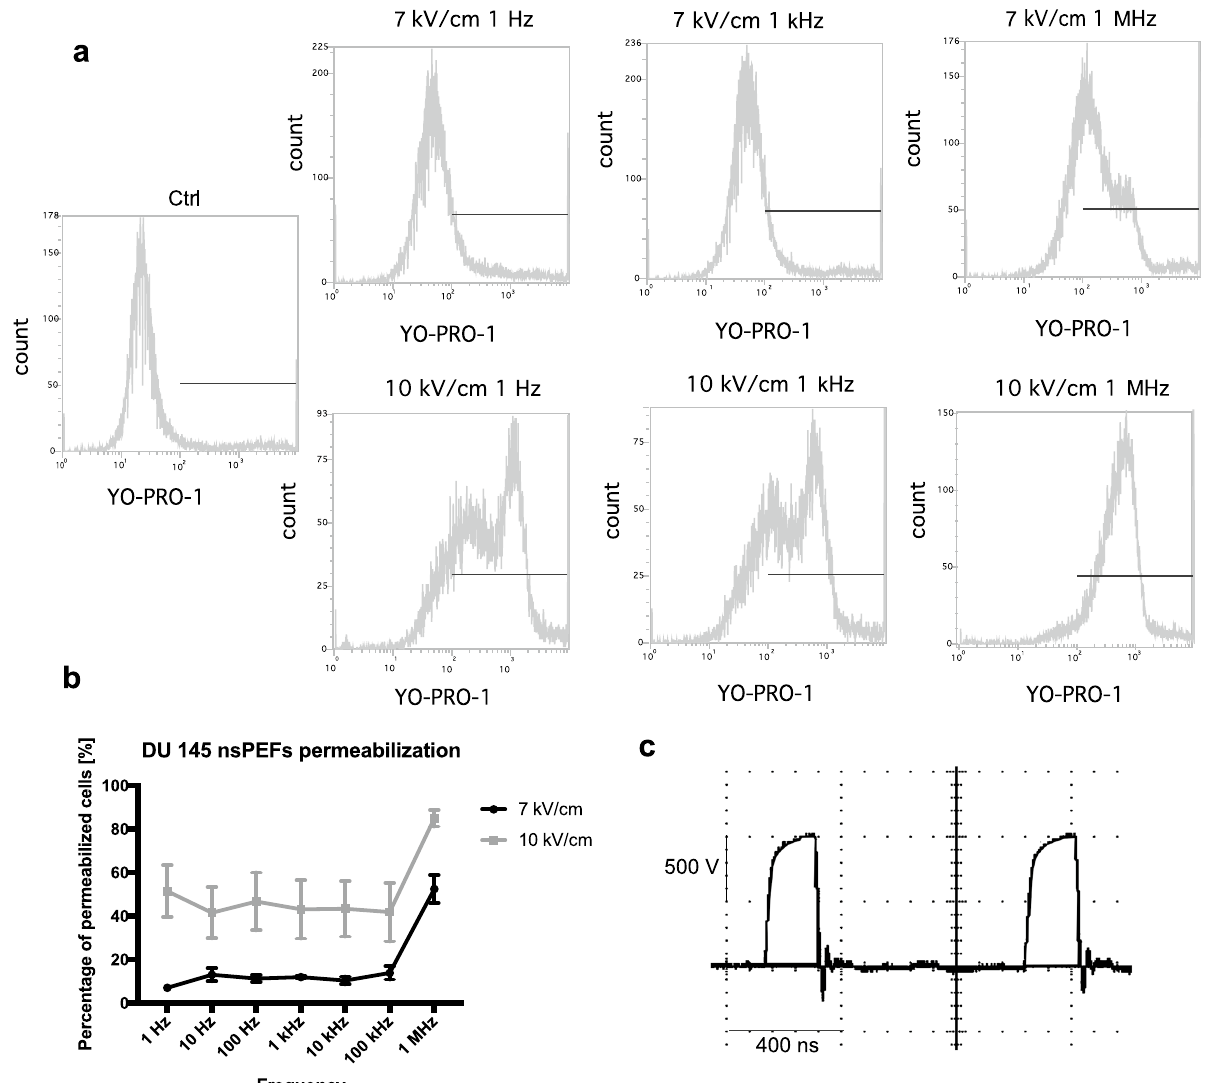
Figure 1. Permeabilization of DU 145 cells by 25, 200 ns PEFs bursts evidenced by YO-PRO-1 dye uptake. Cells were permeabilized in suspension in a 1-mm gap electroporation cuvette. ( a ) Flow cytometry analysis data presented on one-dimensional histograms. The graphs represent the data form one representative experiment. ( b ) The permeability of cells as a function of electric field frequency. The graph is representative of three independent experiments. Data are mean ± SD (n = 3 independent experiments). The effect of nsPEF was measured at two different electric field intensities. 25-pulse, 200-ns bursts become significantly more efficient at MHz. ( c ) The shape of high-frequency nsPEF delivered to 1 mm electroporation